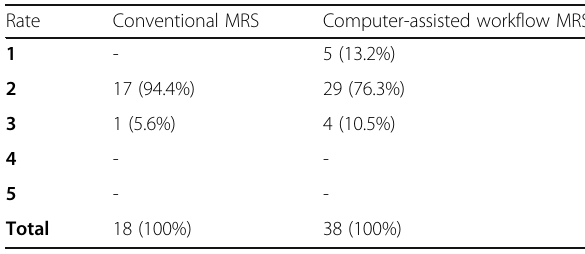
Table 3 Results of saturation pulse